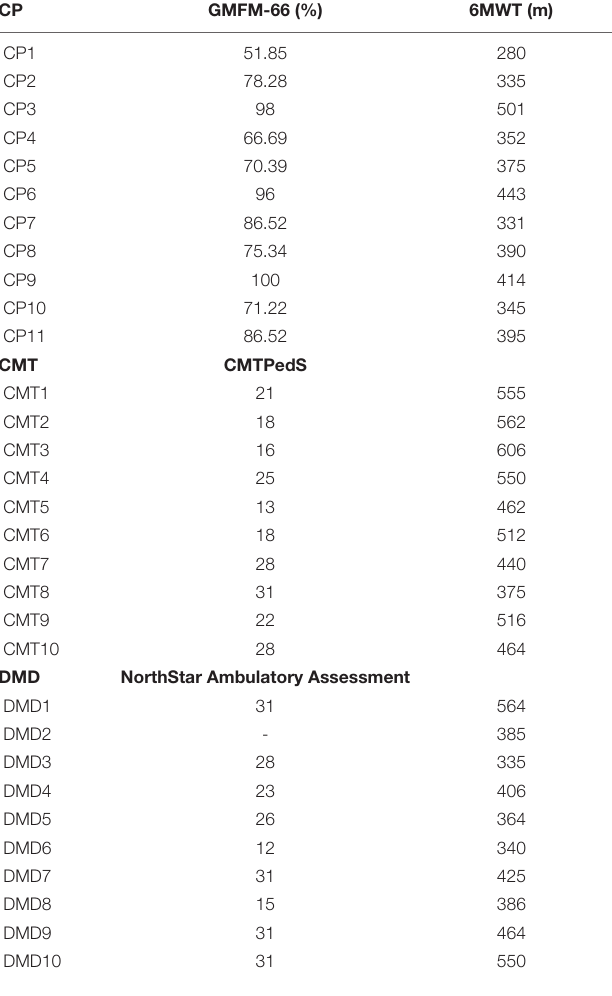
TABLE 1 | Clinical scale and six Minute Walking Test (6MWT): For Cerebral Palsy (CP) the clinical scale used is the Gross Motor Function Measure-66 (GMFM-66), for Charcot Marie Tooth (CMT) the clinical scale is the CMT Pediatric Scale (CMTPedS), and for Duchenne Muscular Dystrophy (DMD) the clinical scale is the NorthStar Ambulatory Assessment